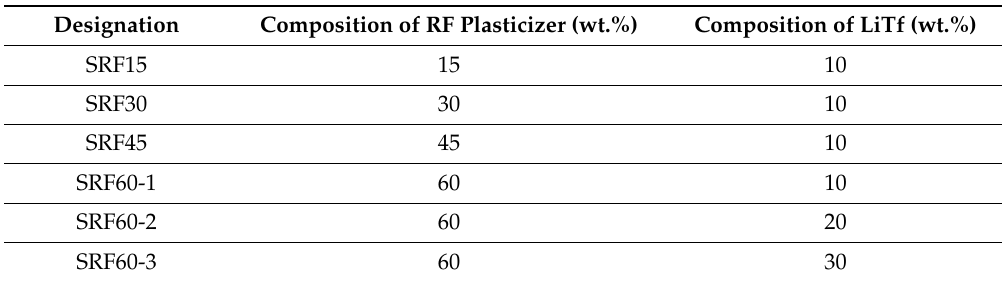
Table1. Composition and the designation of starch:LiTf:resorcinol-formaldehyde (RF) polymer electrolyte. Designation Composition of RF Plasticizer (wt.%) Composition of LiTf